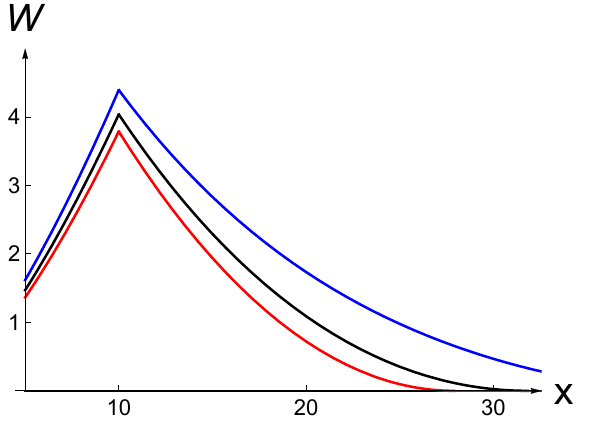
Figure 4. The value of waiting W ( x ) = V ( x ) − ( x − K 1 ) + w.r.t. x for γ = − 0.2 (blue line), γ = 0 (black line) and γ = 0.2 (red line). The parameter set is r = δ = 0.03, σ = 0.3, K 1 = 10, K 2 = K 1 ( 1 + γ ) , λ =